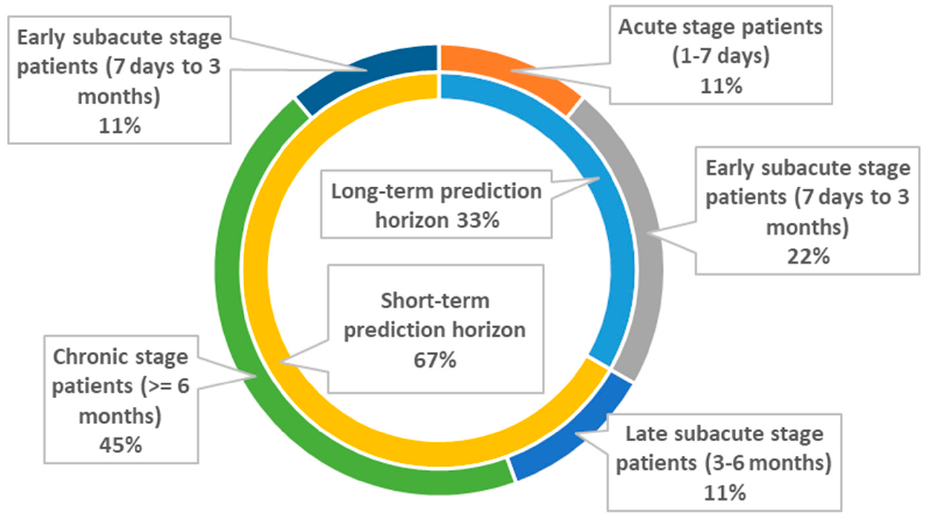
Figure 3. Employed studies in upper extremities category according to prediction